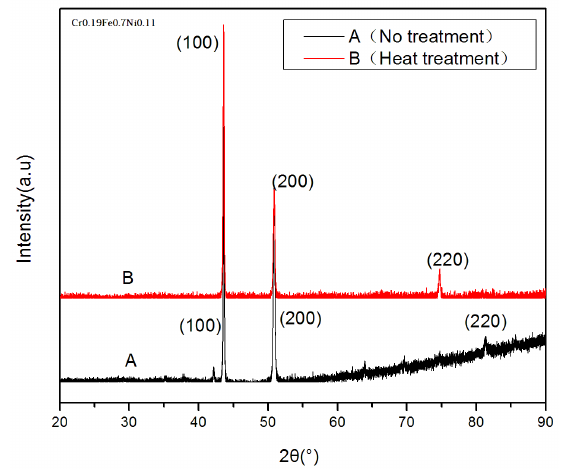
Figure 6. The surface composition of the sample.